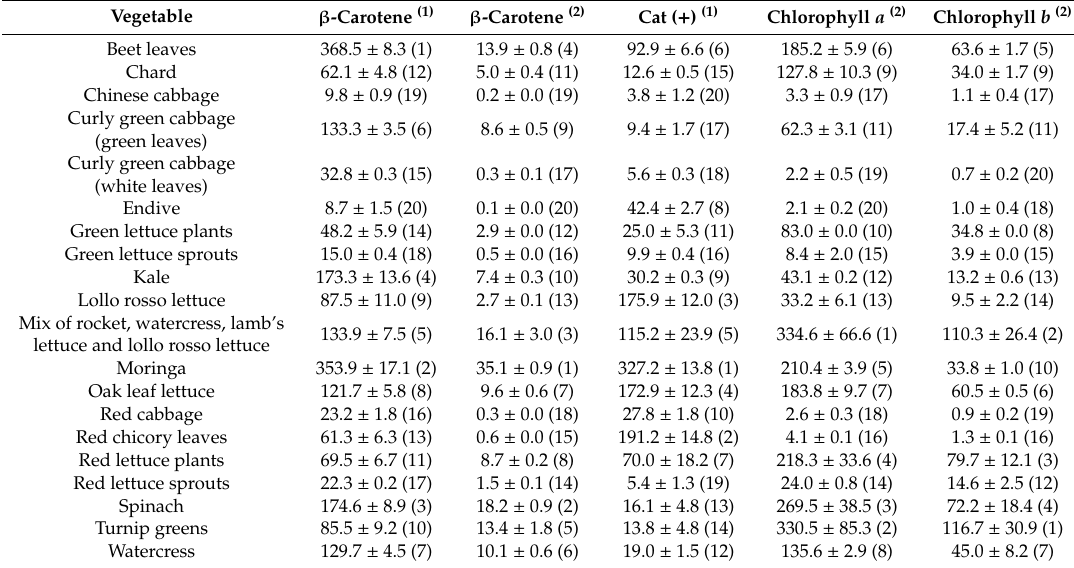
Table 6. Mean values of carotenoids, flavonoids and chlorophyll a and b obtained by methanolic extract (1) and lipophilic extract (2) . All values are expressed as mg / 100 g fresh weight (FW). In parentheses, the rank order of the vegetables according to the values obtained, from highest to